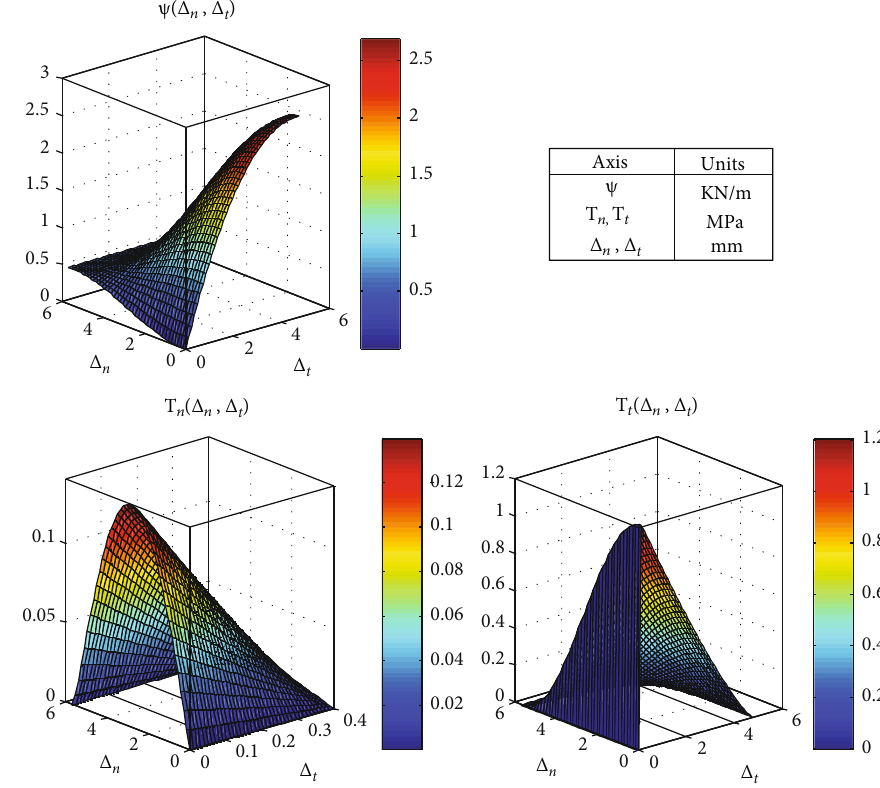
Figure 19: PPR potential and its gradients in SLJ